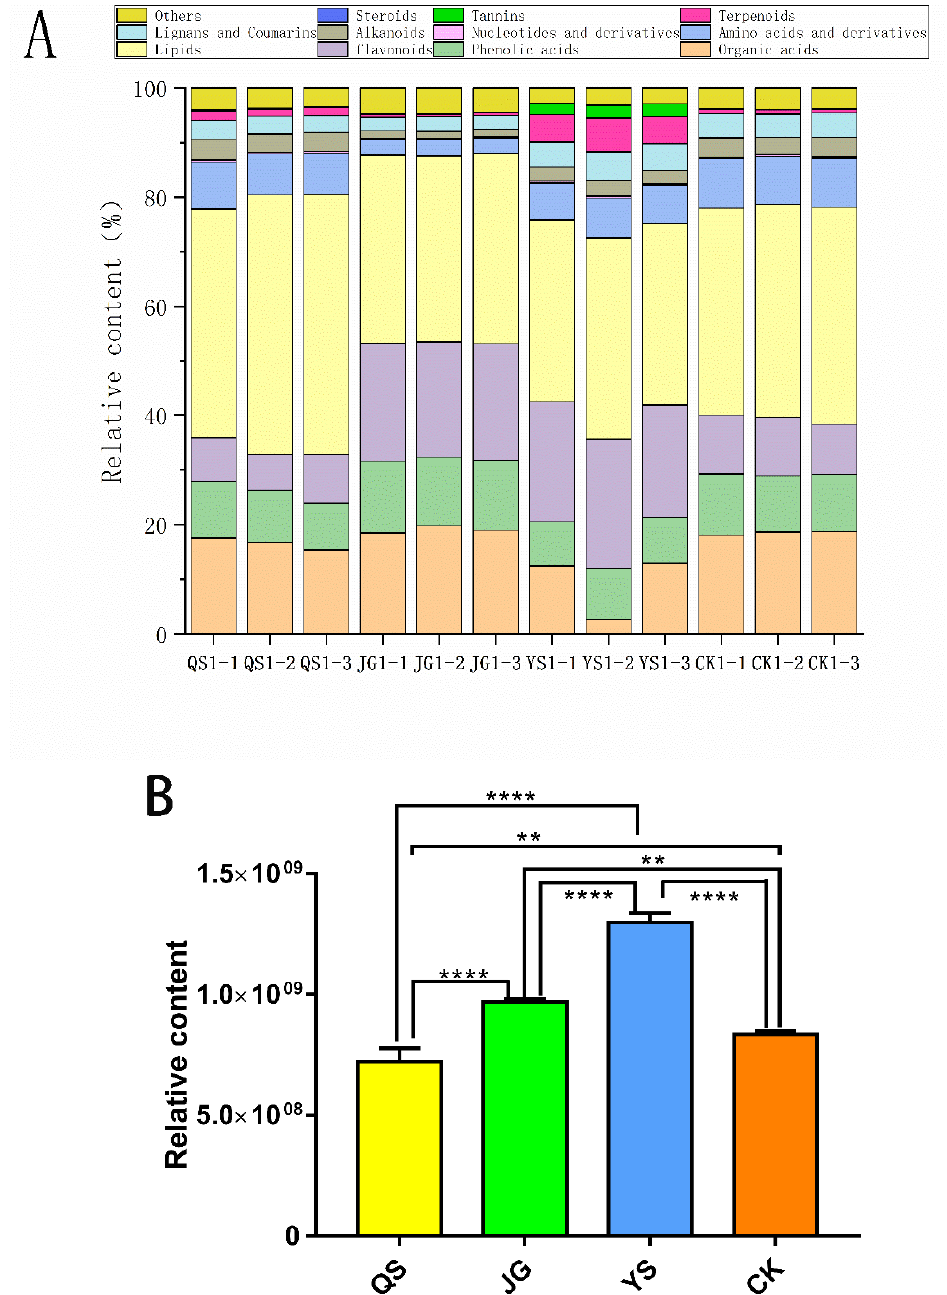
Figure 1. ( A ) Relative content stacked histogram of different metabolite categories. ( B ) One-way ANOVA analysis of total metabolite content of all samples in the experiment. The symbol with two five-pointed stars and the symbol with four five-pointed stars above the histogram indicate statistical significance at the level of 0.01 ( p < 0.01) and 0.0001 ( p < 0.0001), respectively. (8–24%), organic acids (3–19%), phenolic acids (9–13%), and amino acids and their